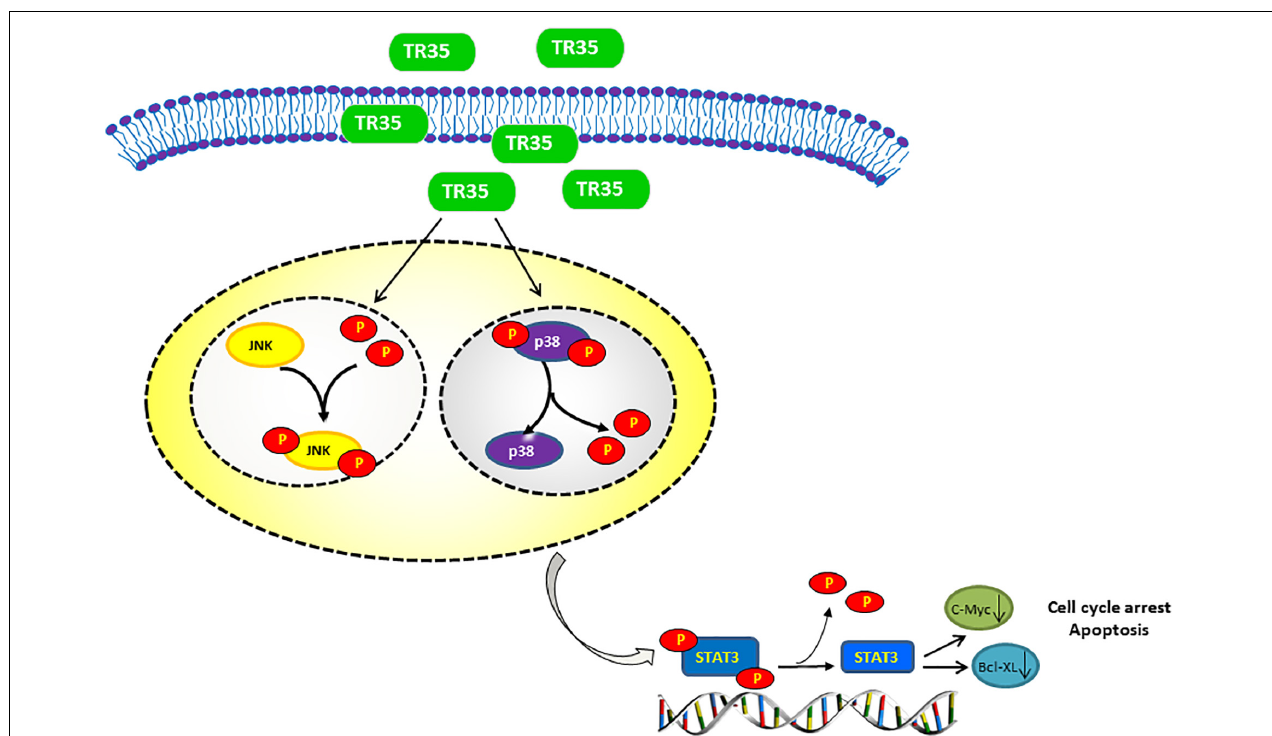
FIGURE 6 | Proposed model of the mechanism underlying the TR35 inhibit NSCLC cell growth and proliferation via MAPK and Jak-STAT signaling pathway. Mechanistically, In TR35 treated NSCLC cells, JNK activation in the JNK-STAT3 signaling axis suppresses STAT3 phosphorylation accompanying the p-p38 downregulation, and thereby suppressing the growth and proliferation of NSCLC